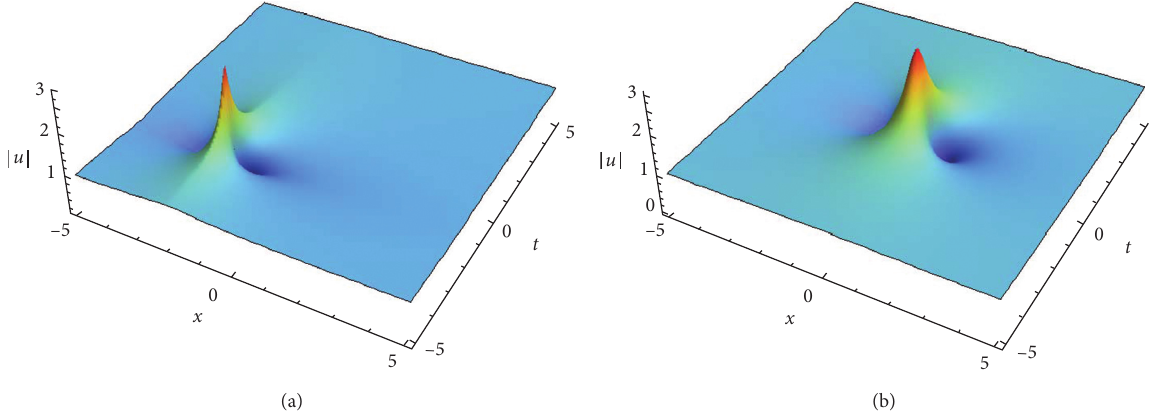
Figure 2: First-order fractional rogue wave solution (color online) (33) and its comparison with the integer order. (a) α � 5/7 and a � − 2; (b) α � 1 and a � 0.